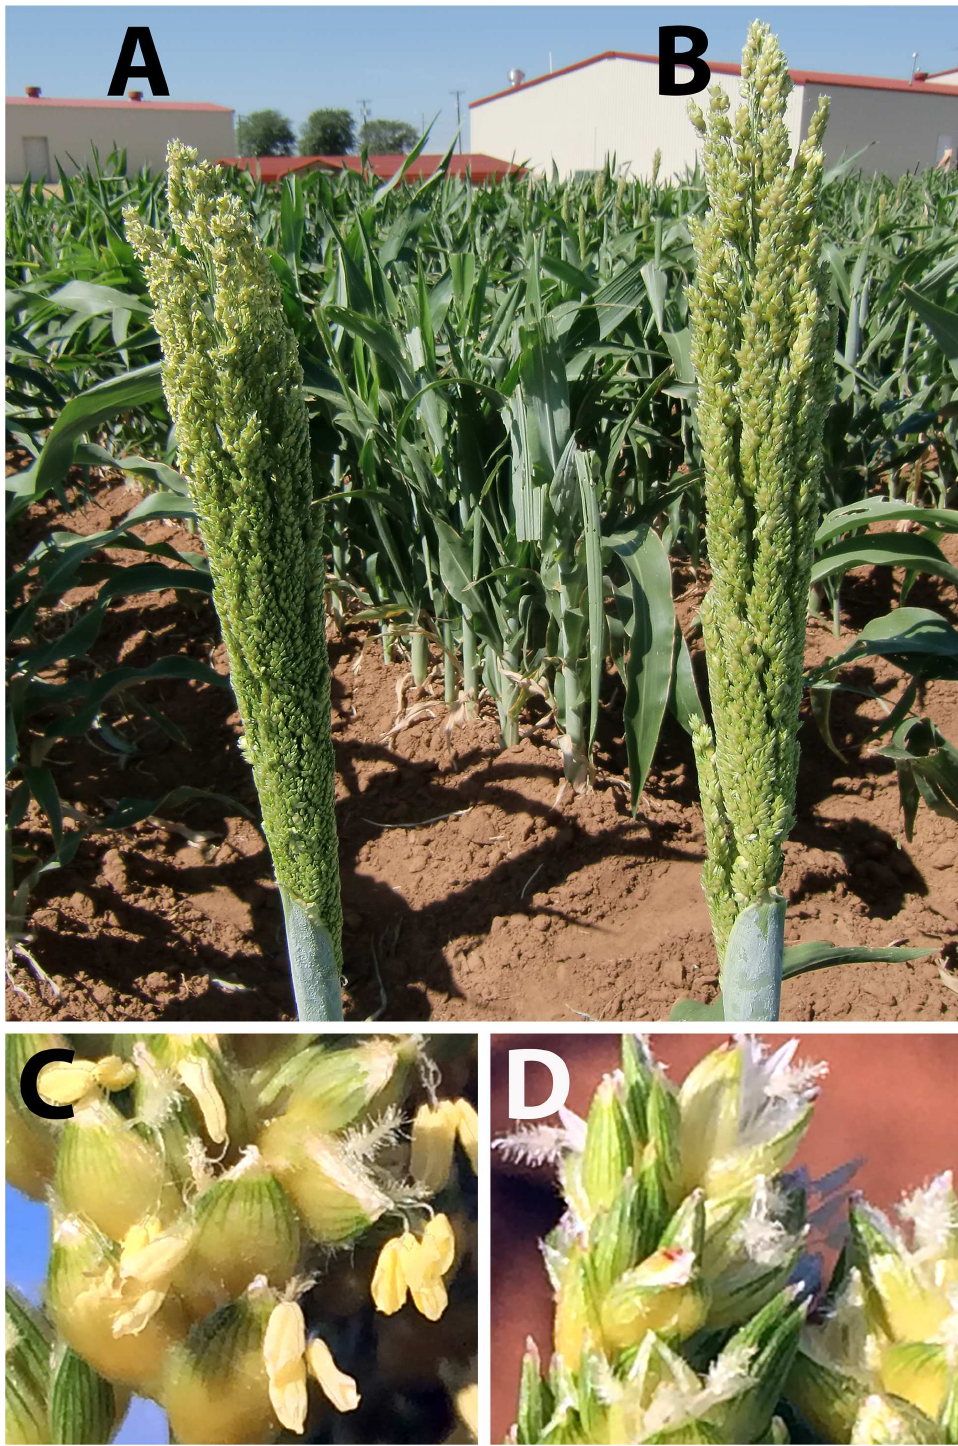
Fig 1. Comparison of BTx623 wild-type panicle and spikelets with that of the ms8 mutant. (A) Fresh yellow anthers were extrudedfrom sessile spikelets of the BTx623 wild-typepanicleat the anthesisstage. (B) Anthers were small and white in ms8 spikelets at the anthesisstage; thus they were nearly invisiblein the panicle. (C) Yellowanthers are shown in BTx623 spikelets at the anthesisstage. (D) White small anthers and hairy stigmas were observedat the anthesis